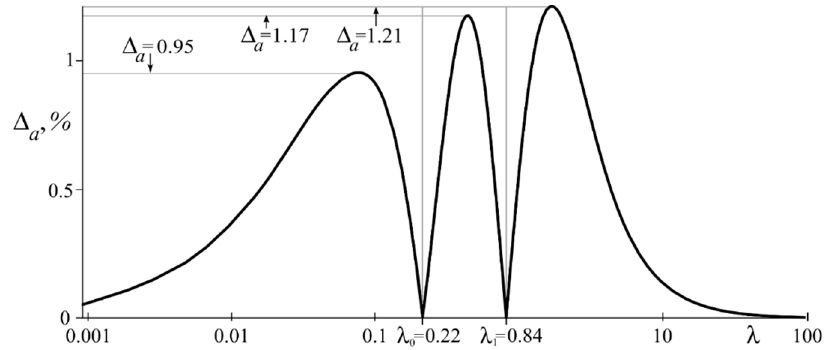
Figure 7. Graph of the relative error Δ a of a simplified expression a P versus relative coating thickness λ for β = 0.5.